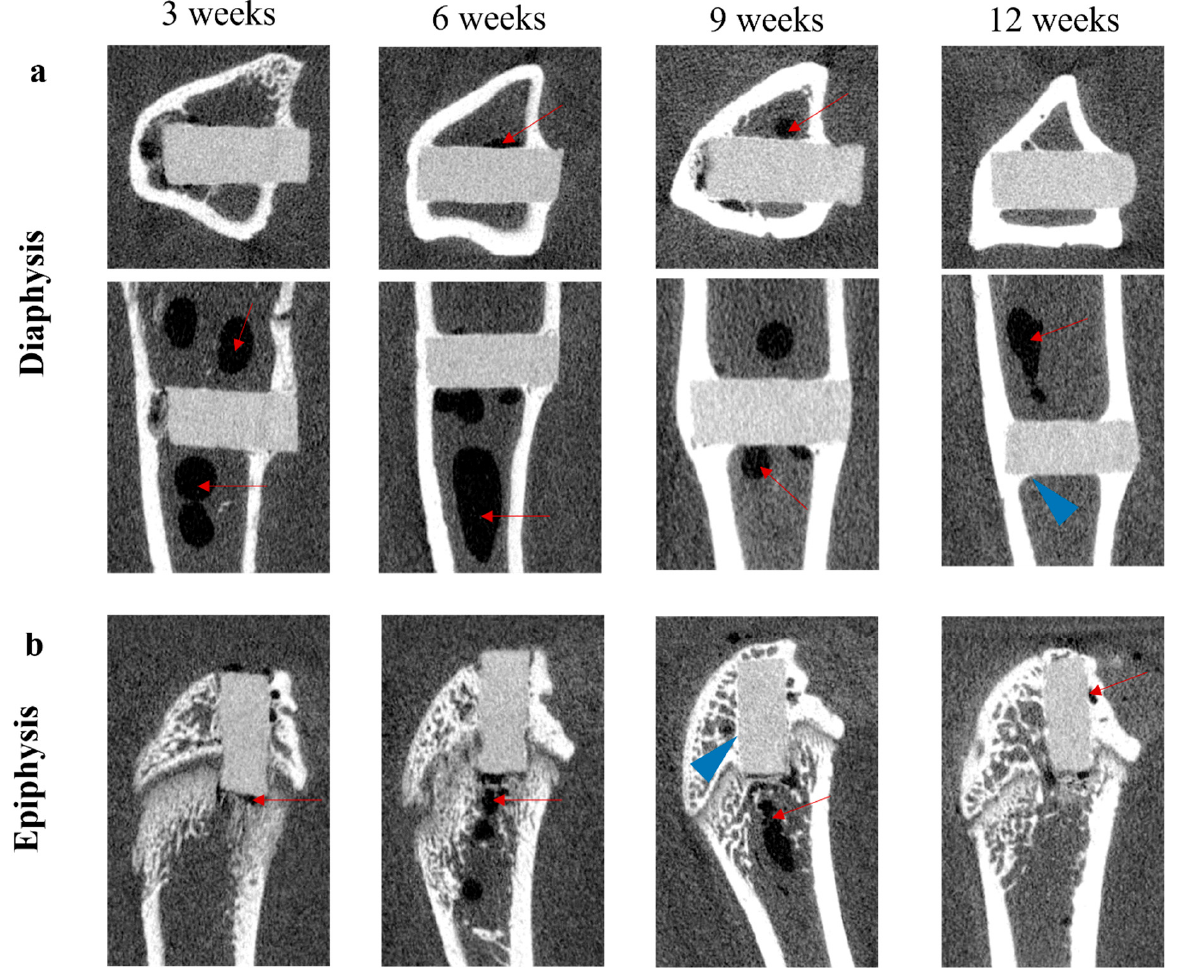
Figure 3. Micro-CT images of Mg rods in tibial diaphysis ( a ) and distal femoral epiphysis ( b ) after implantation in rats for 3, 6, 9, and 12 weeks. The red arrows indicate gas pocket formation, and the blue arrowheads indicate the new bone layers covering the implant surface.